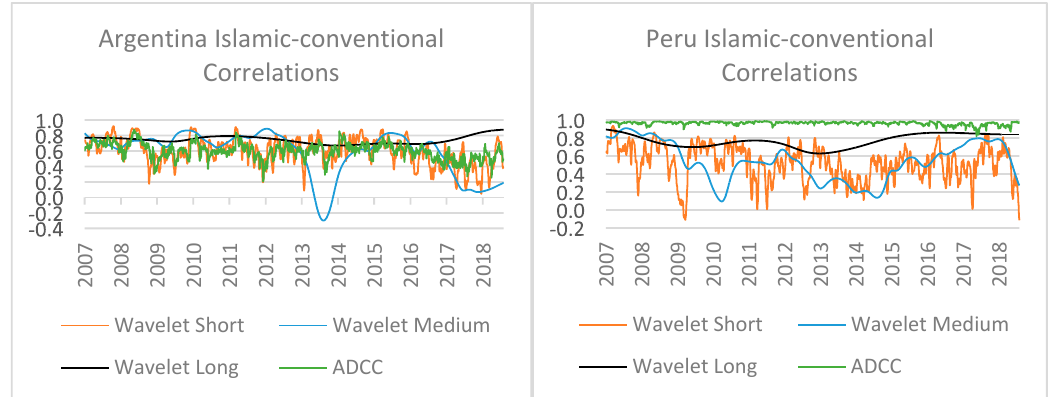
Figure 6 . Wavelet short-, medium-, long-term and ADCC correlations for the Americas Islamic and conventional equity markets.